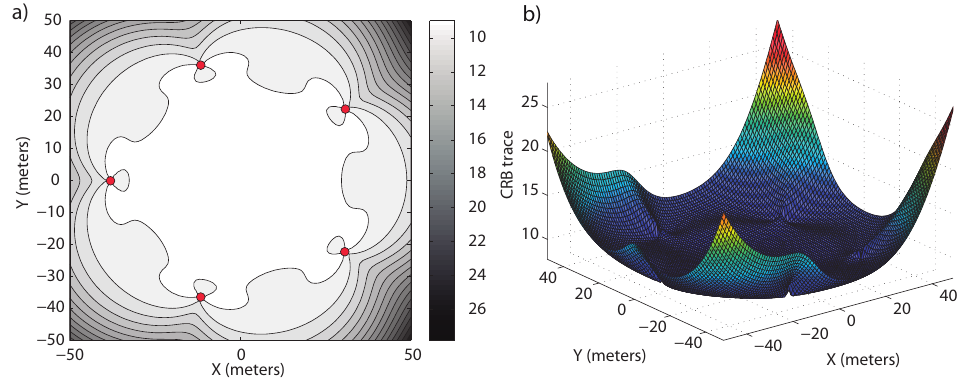
Figure 4. Optimal surface sensor formation for an uncertain target position at a depth of 50 meters, σ = 0 . 05 rad and η = 0 . In ( a ), the level curves of tr ( CRB ) D in ℜ 2 are shown and in ( b ), its magnitude in 3D for D